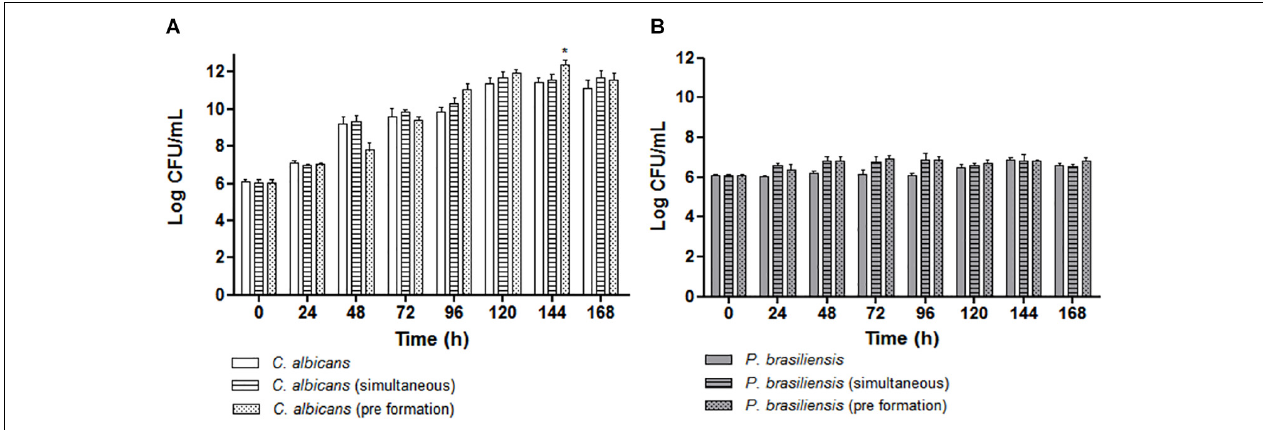
FIGURE 3 | Quantitative analysis of biofilm formation in vitro by CFU/mL (Log10) count for the following groups: (A) Mono-species biofilms formed by C. albicans , co-cultivated C. albicans plus P. brasiliensis biofilms or dual-species biofilms formed by the addition of P. brasiliensis inoculum to preformed 12 h C. albicans biofilms (* p < 0.001). (B) Mono-species biofilms formed by P. brasiliensis , co-cultivated C. albicans plus P. brasiliensis biofilms or dual-species biofilms formed by the addition of P. brasiliensis inoculum to preformed 12 h C. albicans biofilms. Statistical significances were calculated by using analysis of variance (ANOVA) followed by Bonferroni test.